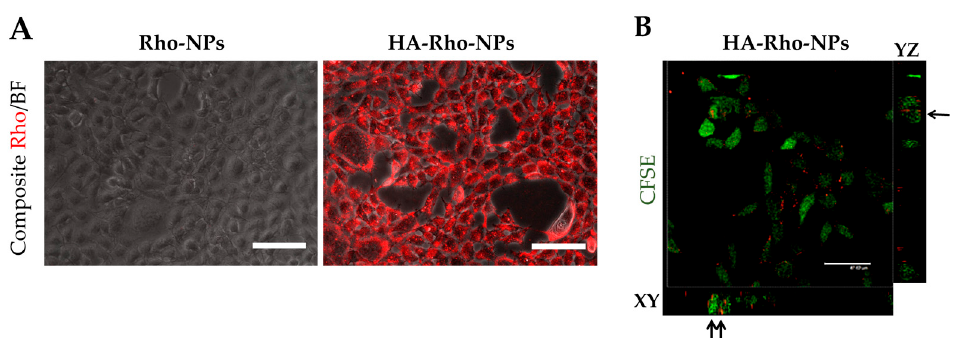
Figure 9. Internalization of HA-Rho-NPs in HEK-293A-CD44v6. ( A ) Internalization of NPs loaded with Rho and conjugated with 22.5 kDa HA (22.5 kDa HA-Rho-NPs) into HEK-293A-CD44v6.; cells were incubated with NPs for 4 h at 37 °C and then washed multiple times to eliminate excess of NPs; Rho signal in red, bright field (BF) in gray; scale bars: 100 µm. ( B ) Z-stack analysis of the internalization of HA-Rho-NPs (0.1 mg/mL) in HEK-293A-CD44v6. A CFSE cell tracer was used to stain the cytoplasm of cells (in green). XY and YZ correspond to the frontal and sagittal planes, respectively. Black arrows show Rho signal in correspondence to the CFSE signal in frontal and sagittal planes. Scale bars: 47.62 µm.